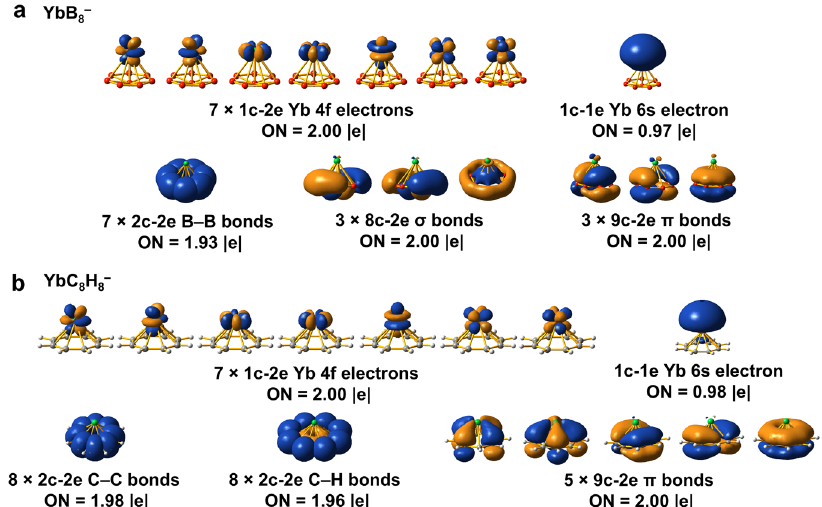
Fig. 4 AdNDP bonding analyses of YbB 8 − and comparison with that of YbC 8 H 8 − . a YbB 8 − ( C 7v , 2 A 1 ). b YbC 8 H 8 − ( C 8v , 2 A 1 ). The occupation numbers (ONs) are indicated.